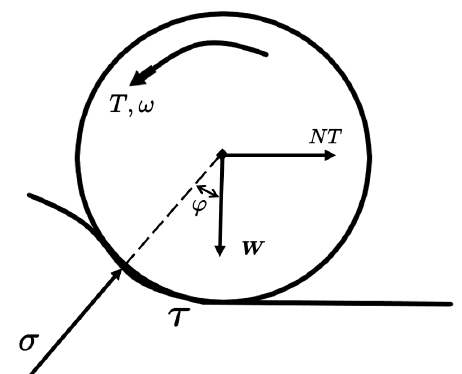
Figure 9. Schematic of soil–tyre interaction. Total driving torque on the wheel (T), the angular velocity of the wheel ( ω ), net traction (NT), the angle between normal stress and the vertical ( ϕ ), vertical load (W), normal stress ( σ ) and shear stress ( τ ).